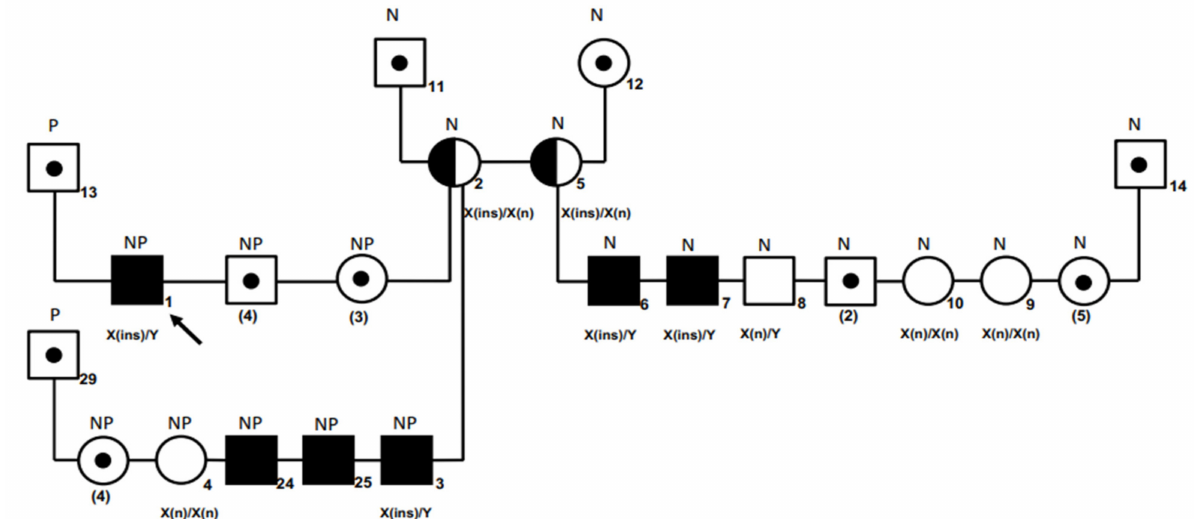
Figure 3. Pedigree of a hemophiliac Newfoundland–Parti Standard Poodle family, with results of genotyping and aPTT results. Squares and circles represent males and females, respectively. Filled symbols indicate clinically bleeding male dogs hemizygous for the F9 variant and/or having a prolonged aPTT. All affected animals displayed abnormal bleeding. Half-filled symbols indicate females who are carrier of the F9 variant. The black arrow refers to the index case (Case #1). Symbols with a dot but with numbers in brackets indicate number of dogs that were not available for genotyping. The six male offspring in this category had normal aPTTs (squares with dot). Genotyping results are shown below each square or circle (X and Y represent the X- and Y-chromosomes; (n), wild-type; (ins), insertion (NM_001003323.2:c.821_822insA